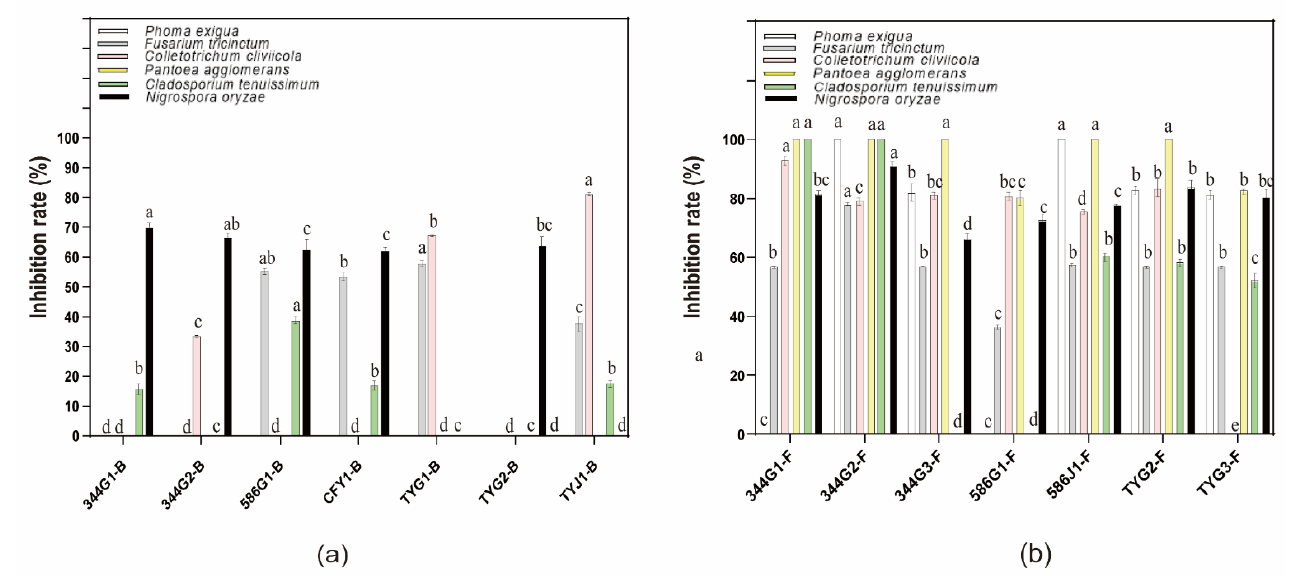
Figure 3. Inhibition rate of endophytic fungi and bacteria: ( a ) is endophytic bacteria of inhibition rate; ( b ) is endophytic fungi of inhibition rate. Different letters on bars mean significantly different at p < 0.05.